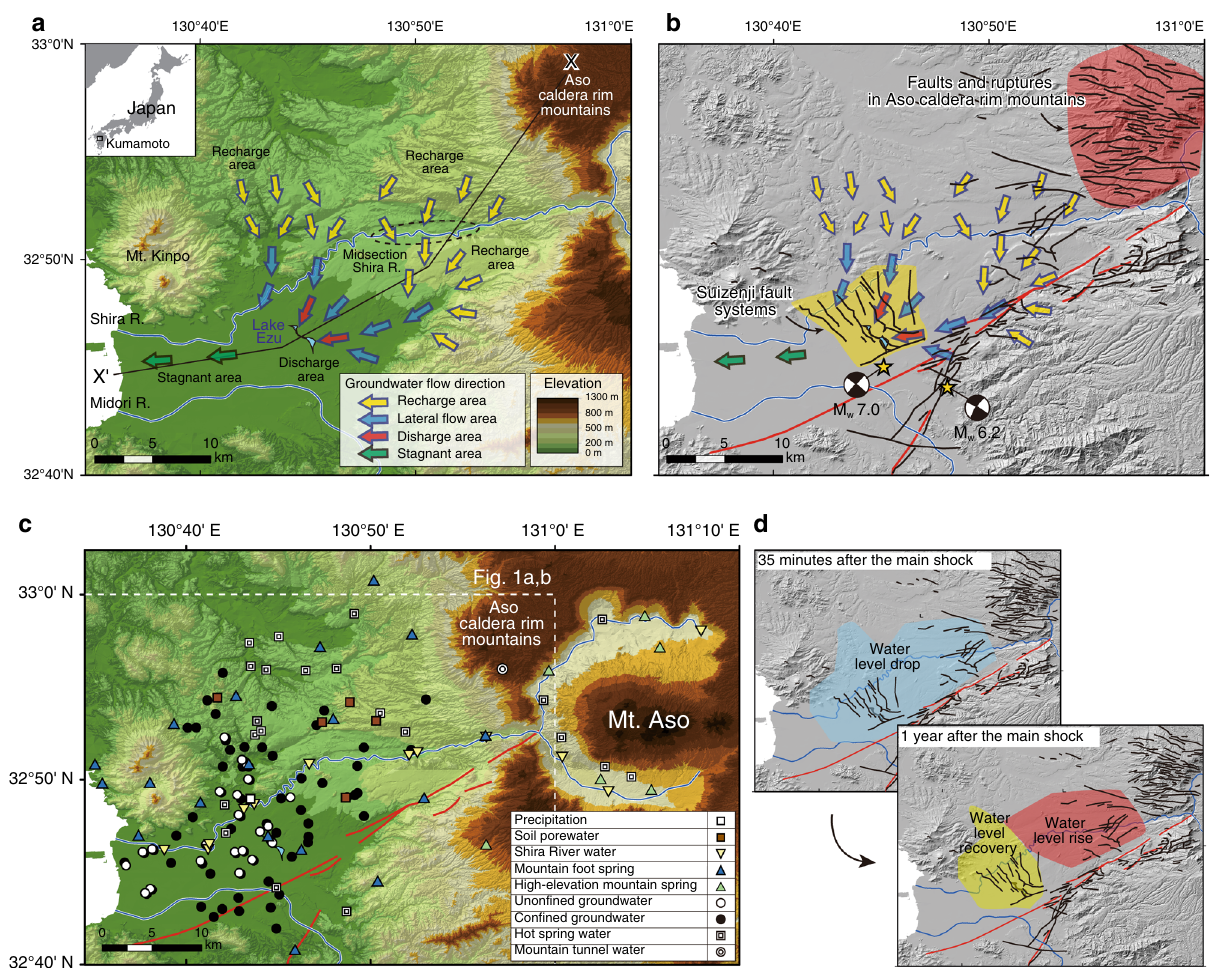
Fig. 1 Hydrogeology and seismotectonics of Kumamoto. a Map showing original hydrological systems in the study area before the 2016 Kumamoto earthquake 6 . Flow directions in each area of the con fi ned aquifer are shown with arrows of different colors. b Seismotectonic structures crosscutting regional groundwater fl ow systems after the 2016 Kumamoto earthquake. Distributions of the foreshock and main shock epicenters (stars) with their mechanisms (beach ball plots), pre-existing fault systems (red lines), and locations of newly recognized ruptures (black lines) are from refs. 6, 21 . c Sampling locations for various waters used for isotopic comparisons. d Cartoon showing the areas where groundwater level changed 35 min and 1 year after the main shock (see Supplementary Fig. 2 for detailed water level change distributions). Hydrogeological cross-section X – X ′ is shown in Fig.